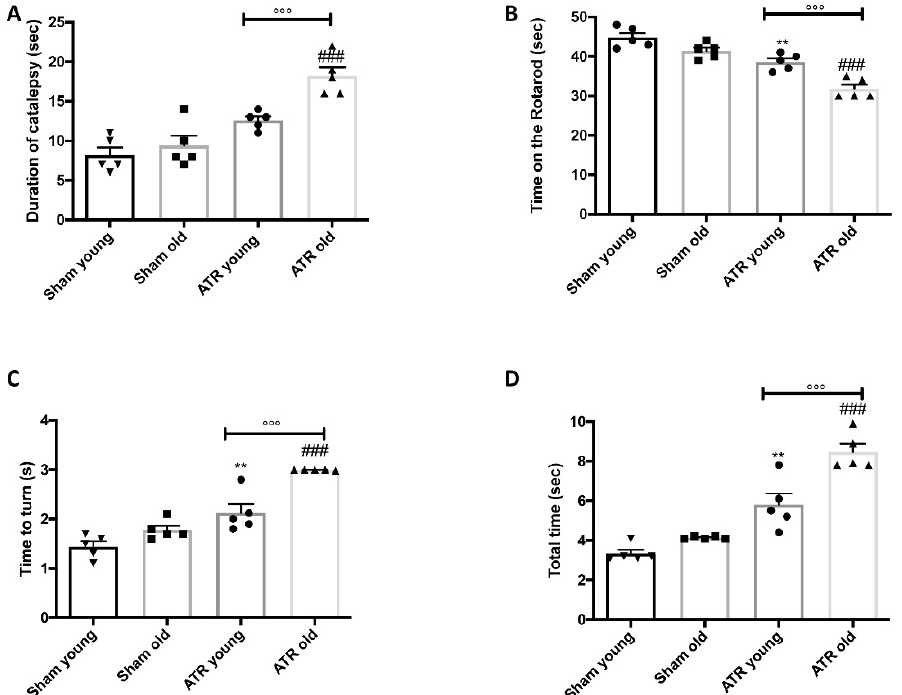
Figure 3. Effect of ATR inhalation on motor functions. Catalepsy test ( A ); Rotarod test ( B ); Time to turn ( C ) and Total time ( D ) for pole test. Aged mice were more susceptibility compared to young to develop motor deficits after ATR inhalation. Data is expressed as the mean ± SEM of n = 5 animals for each group. ** p < 0.01 vs. Sham young; ### p < 0.001 vs. Sham old; ◦◦◦ p < 0.001 ATR old vs. ATR young.